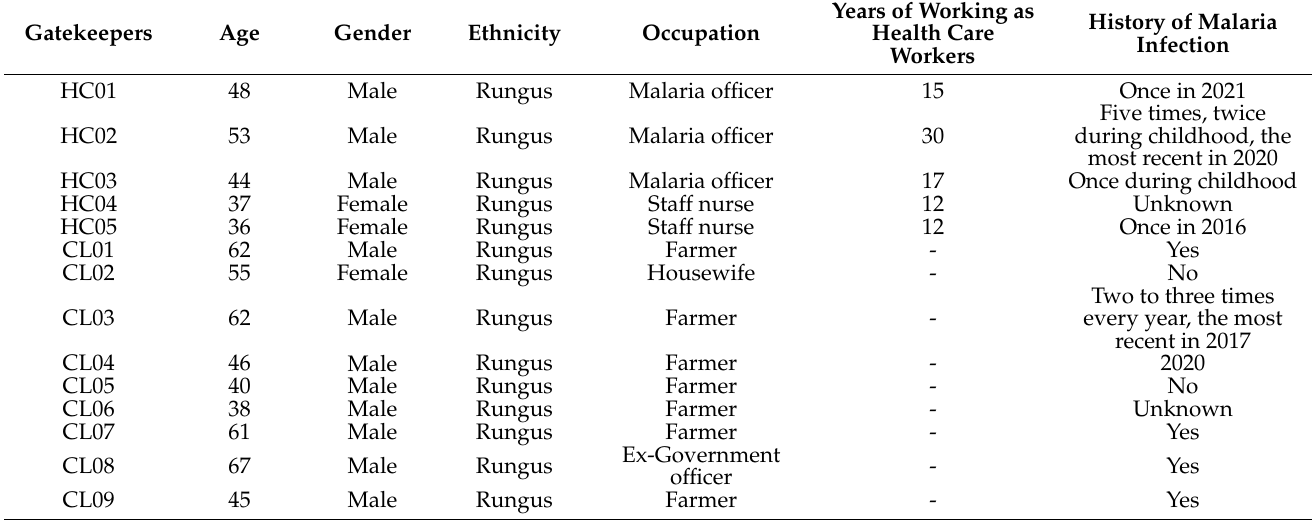
Table 1. Characteristics of study